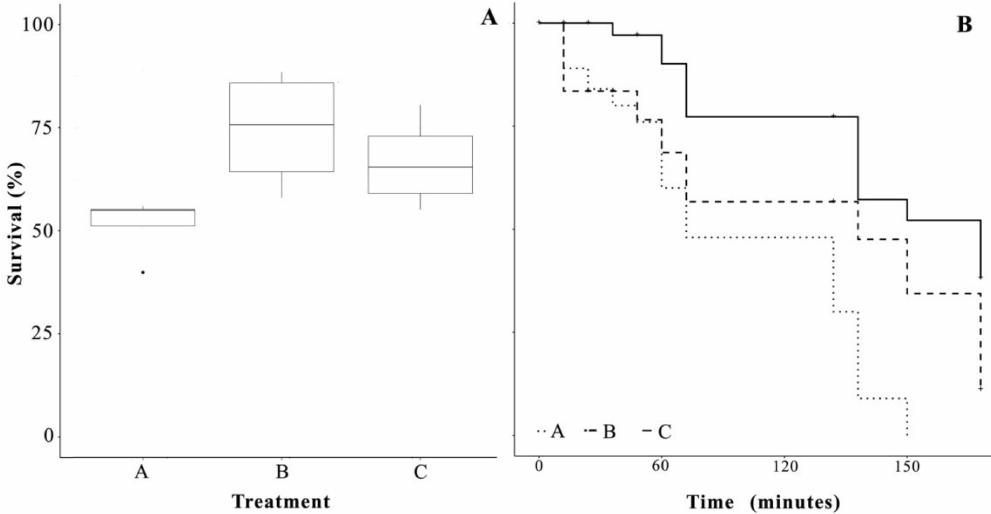
Figure 1. ( A ) Larval survival percentage, ( B ) Salinity stress test mortality during 3 h (n = 100), after 21 dph. Dots shown are the out layers, whiskers indicate the maximum and minimum values excluding out layers, the line in the middle of box is the median value, and upper and lower quartiles are the ends of the box. Statistically significant di ff erences between treatments are marked with an